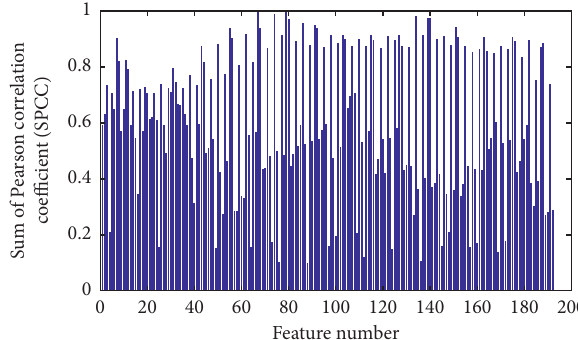
Figure 12: The sum of the Pearson correlation coefficient.